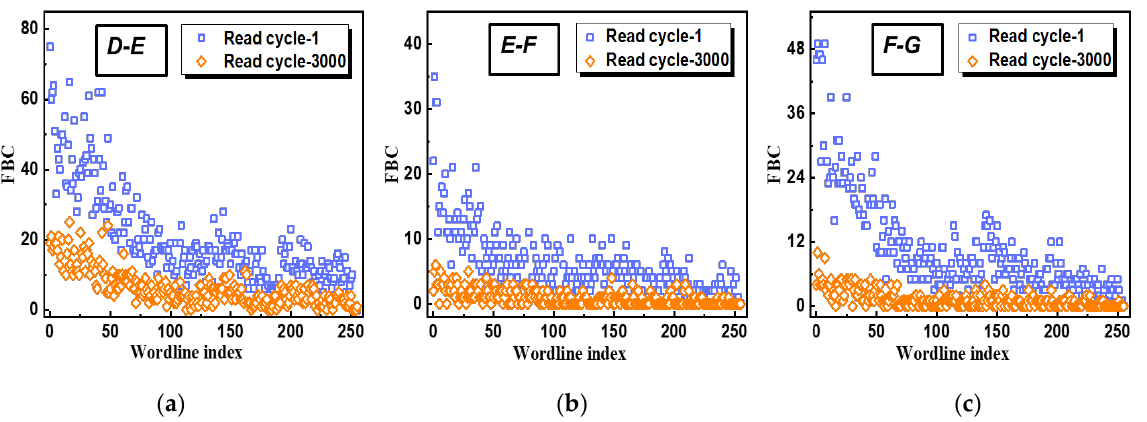
Figure 7. Measured fail bit count (FBC) of different program levels: error bits from ( a ) D-to-E; ( b ) E-to-F; ( c ) F-to-G.